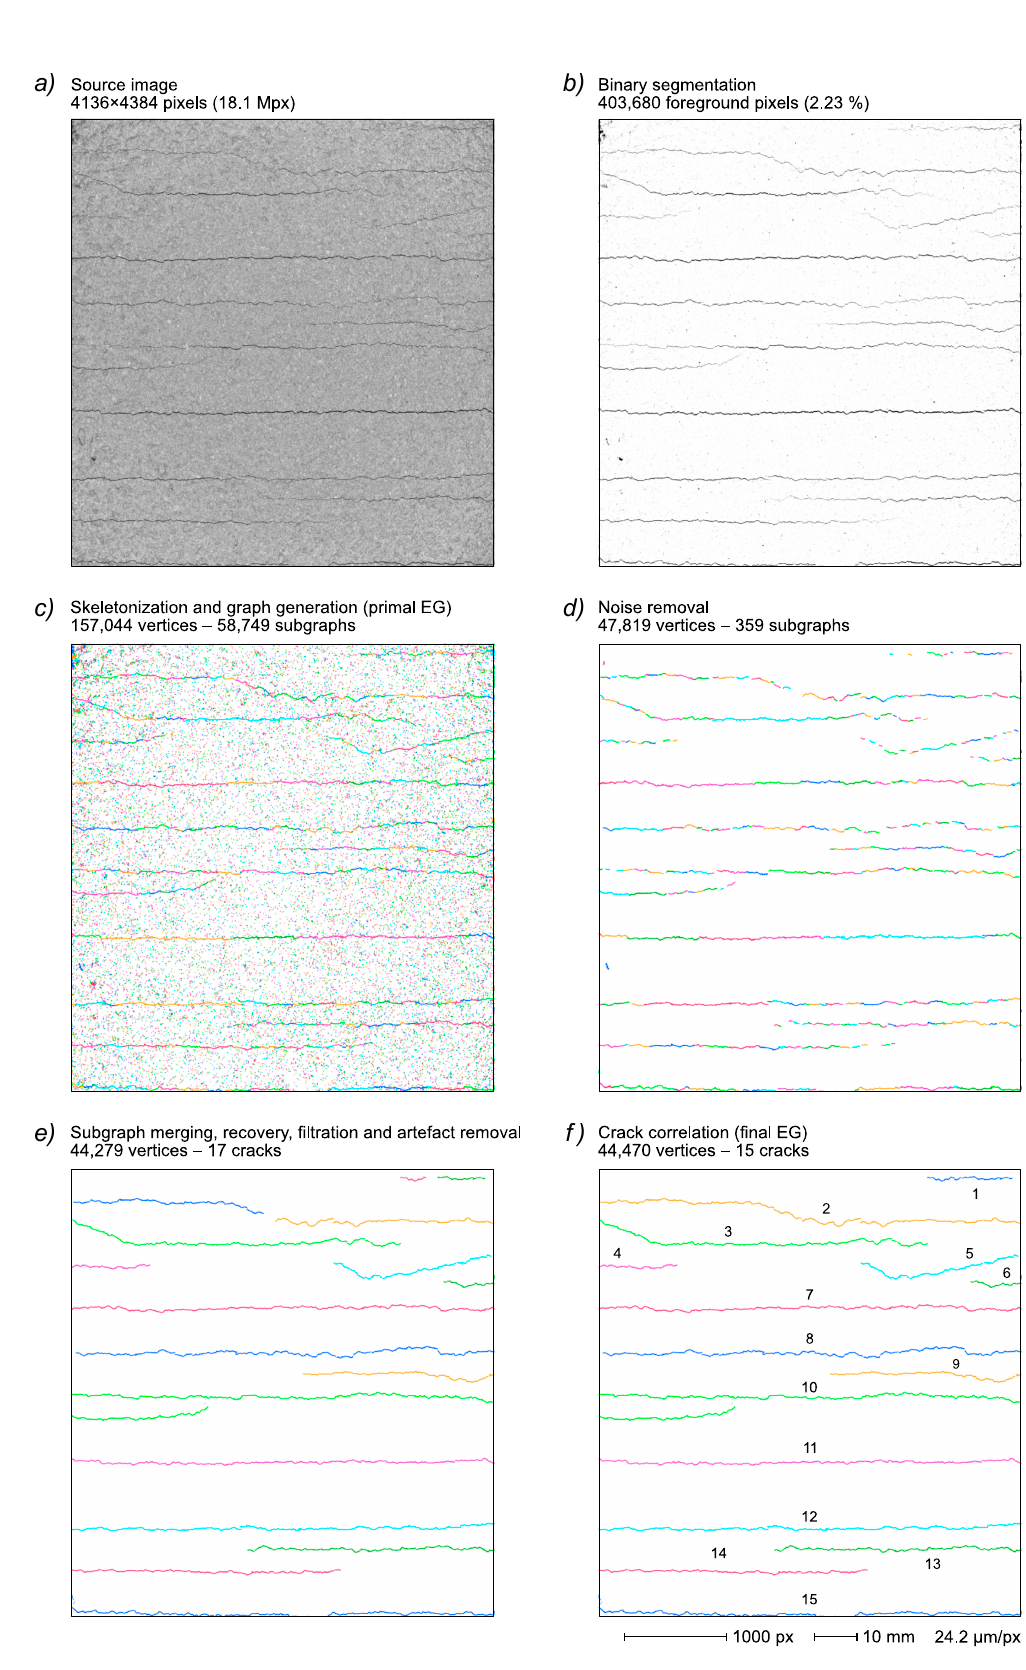
Figure 4. Complete final EG generation from a 1.5% strained sample image. Original image ( a ); binary segmentation ( b ); primal EG after skeletonization ( c ); noise removal ( d ); subgraph merging, recovery, filtration and removal of crack artefacts ( e ); final EG after crack correlation ( f ). Colors indicate different subgraphs/cracks. Distal edges not shown.